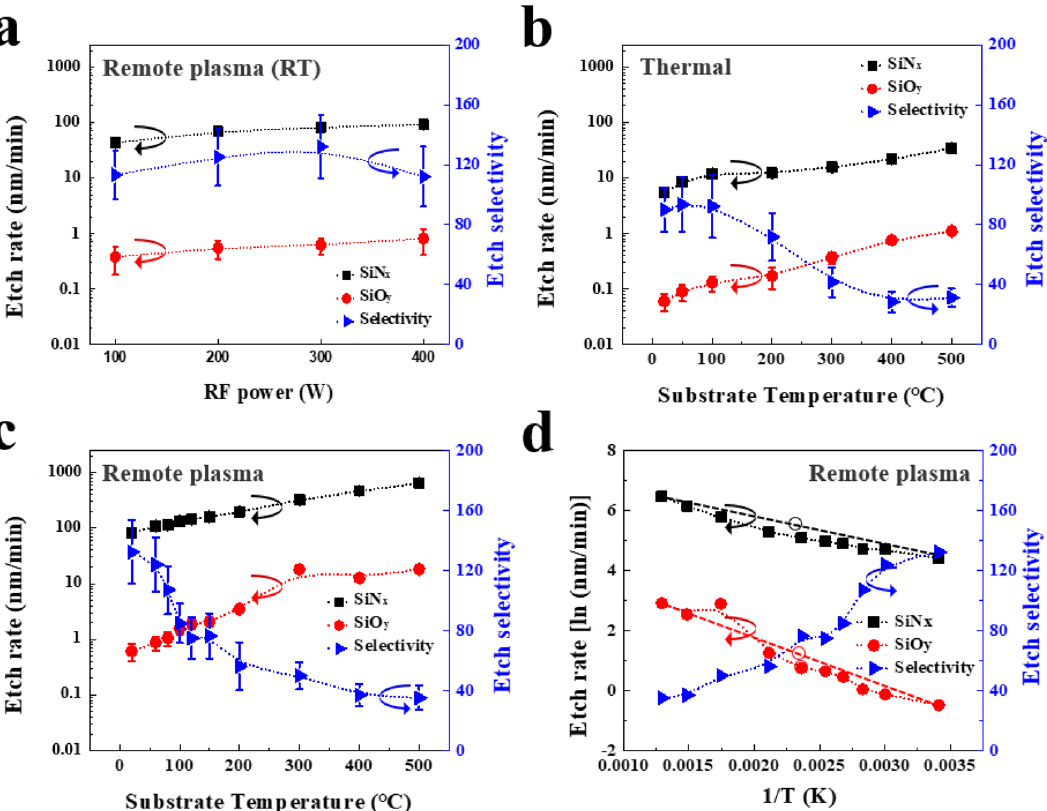
Figure 2. Etch characteristics of SiN x and SiO y ( a ) as a function of rf power for ClF 3 remote plasma at RT, ( b ) as a function of substrate temperature for chemical etching with ClF 3 gas flow only, and ( c ) as a function of substrate temperature for ClF 3 remote plasma at 300 W of rf power. 200 sccm Ar (200 sccm) was added to ClF 3 for plasma stability. ( d ) logarithm etch rates versus 1/T for ClF 3 remote plasma etching of SiN x and SiO y in ( c ) for the extraction of the activation